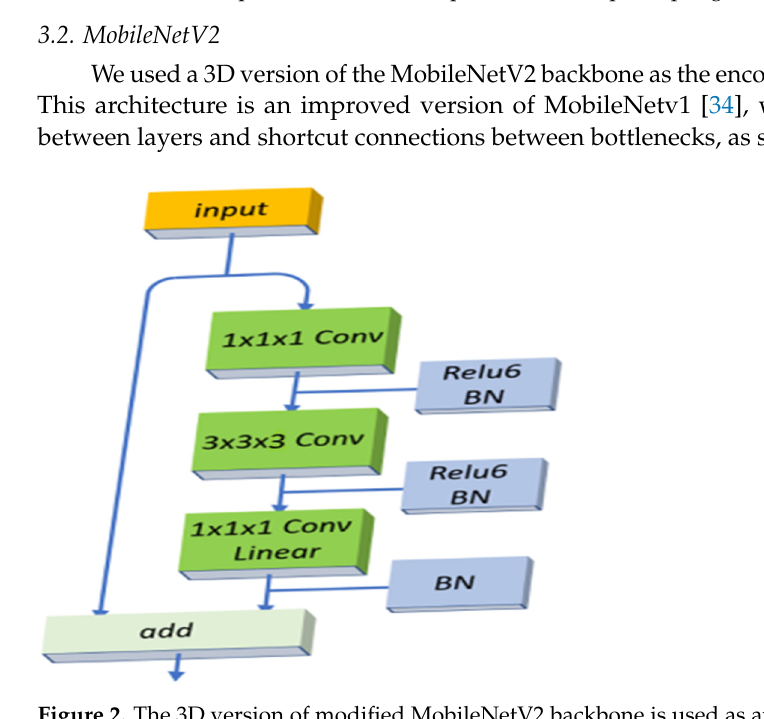
Figure 2. The 3D version of modified MobileNetV2 backbone is used as an encoder block.